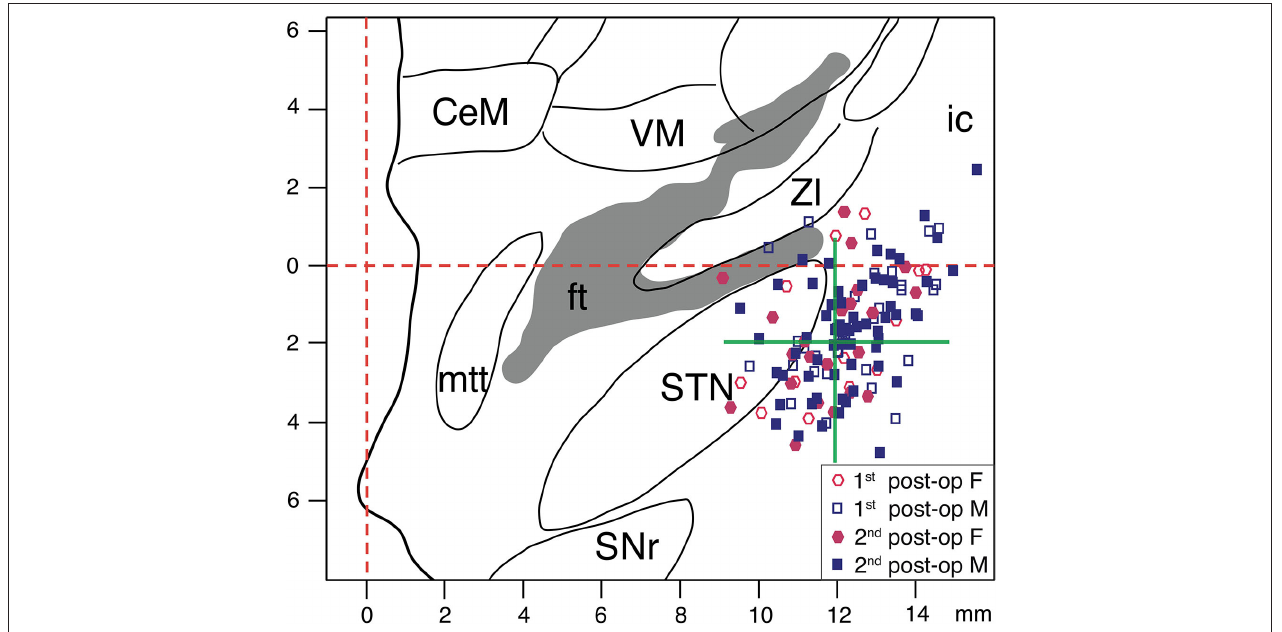
FIGURE 7 | Stereotactic reconstruction of active DBS contacts. The active DBS contacts for both hemispheres are superimposed on a frontal section of the stereotactic atlas of Morel et al., at mid-commissural point level (69). Empty and filled circles represent the active contacts for female patients at the 1st and 2nd post-operative stages, respectively. Empty and filled squares represent the active contacts for male patients at the 1st and 2nd post-operative stages, respectively. The interrupted red lines indicate midline and AC-PC level. The green cross represents the averaged stereotactic target coordinates aimed for the study group. In patients with two adjacent active contacts (cathodes), the averaged x, y, z stereotactic coordinates of those pairs have been plotted. CeM, centralmedialnucleus; ft, fasciculus thalamicus; ic, internal capsule; mmt, mammillothalamic tract; SNr, substantia nigra, pars reticulata; STN, subthalamic nucleus; VM, ventral medial nucleus; ZI, zona